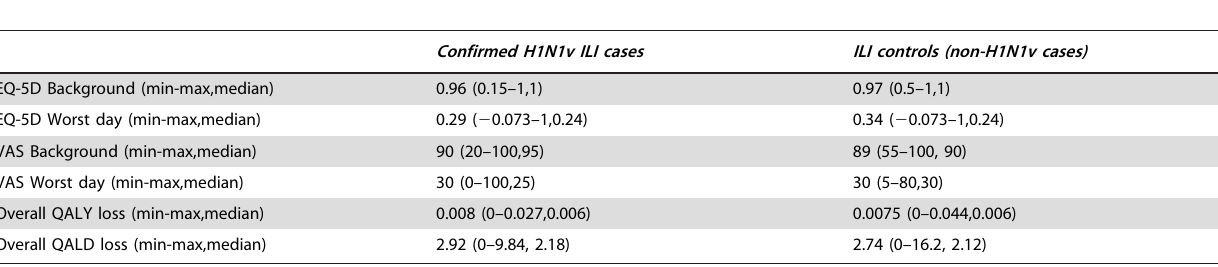
Table 4. Impact of ILI on health related quality of life for H1N1v confirmed and non-H1N1v ILI control